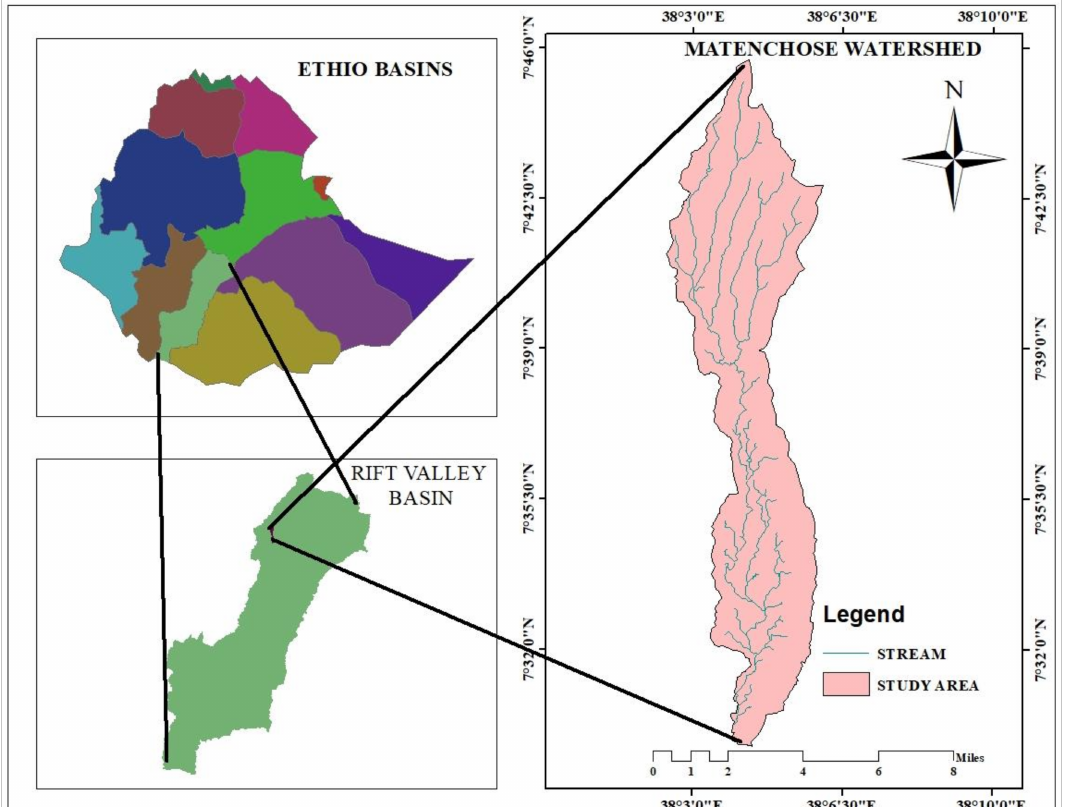
Figure 1. Matenchose watershed